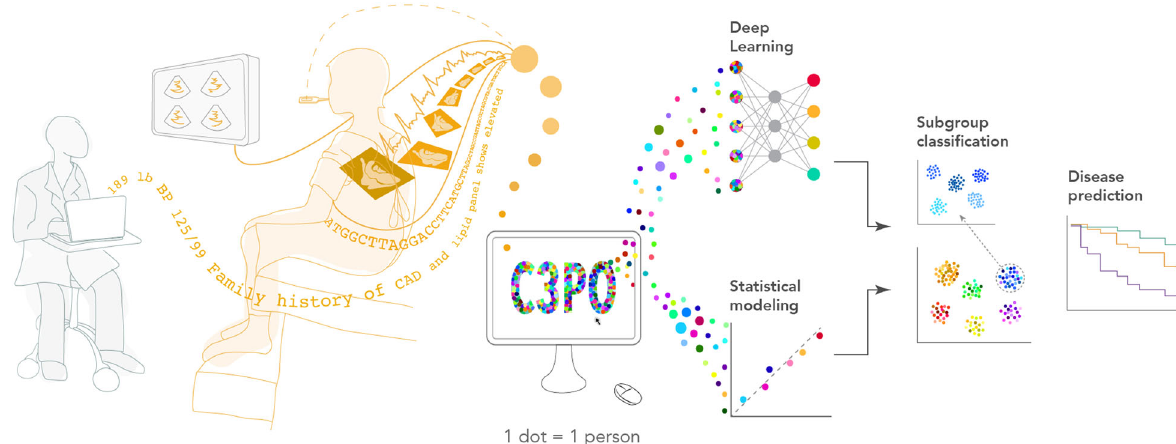
Fig. 8 Conceptual overview of C3PO analysis methods. Depicted is a graphical overview of the potential analyses enabled by the Community Care Cohort Project (C3PO). By integrating diverse data types (e.g., diagnoses, imaging, vital signs, diagnostic test data, genetics), C3PO may enable methods such as traditional statistical modeling and deep learning to facilitate more accurate disease risk prediction models and enable deep phenotyping including disease subgroup identi fi